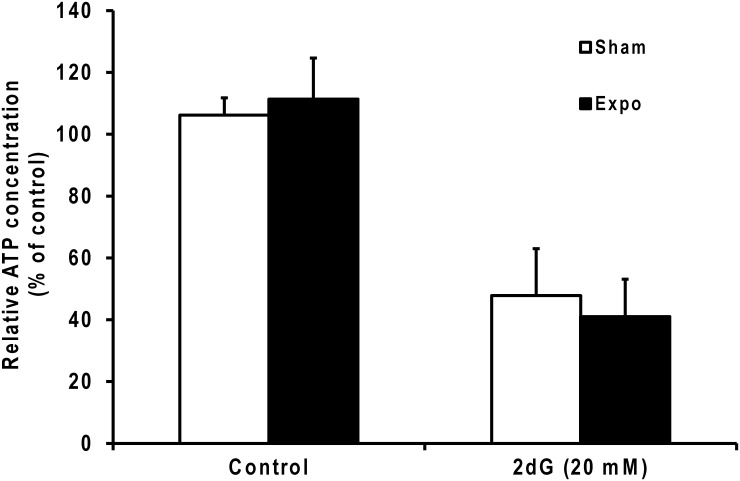
Relative cellular ATP concentration.HaCaT cells were treated with or without 20 mM 2dG for 3 h. Additionally, cells were exposed (black histograms) or unexposed (white histograms) to 60.4 GHz (20 mW/cm2). Data are presented as the mean of four independent experiments and are expressed as the percent of an independent unexposed control that was set to 100%.